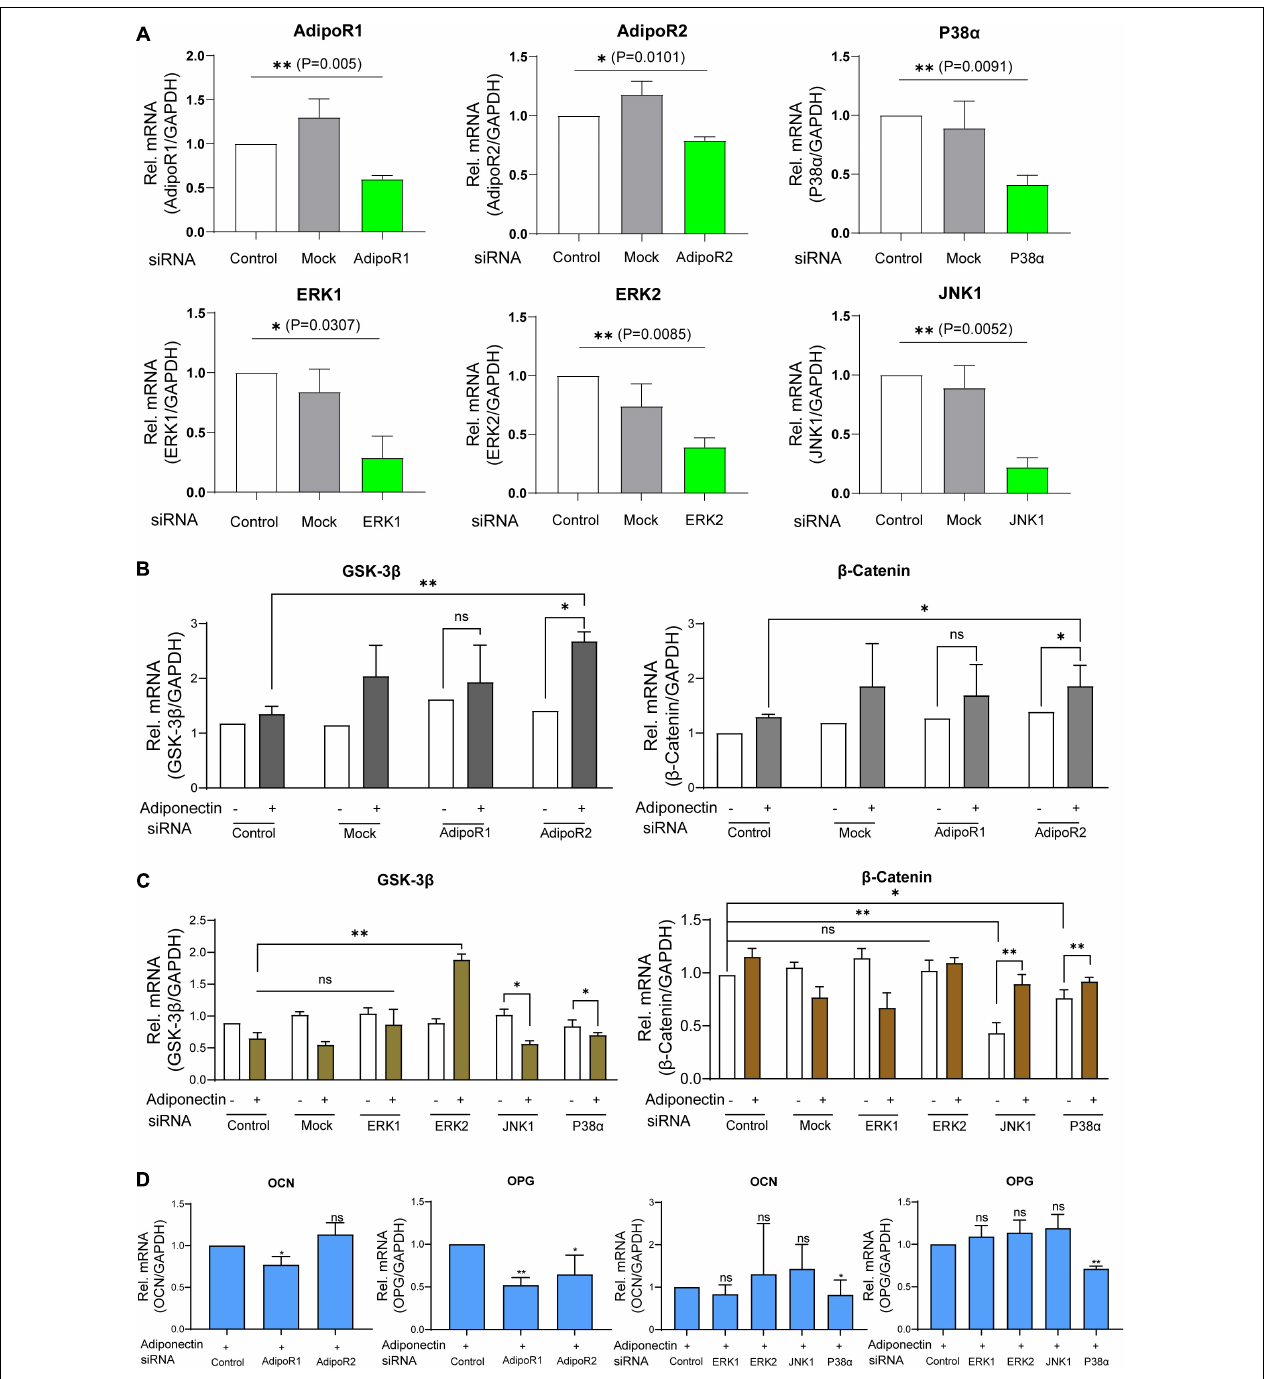
FIGURE 5 | Adiponectin/AdipoR1/P38 α cascade is particularly involved in adiponectin-induced cementogenesis. (A) The efficacy of siRNA transfections was analyzed by RT-PCR analysis. (B) Single knocking down of AdipoR2 in the presence of adiponectin has a positive effect on GSK-3 β gene expression and significantly increases β -catenin expression ( ∗ p < 0.05). (C) The single silencing of ERK2 causes increased gene expression of GSK-3 β after adiponectin addition ( ∗∗ p < 0.01). Silencing of P38 α and JNK1 slightly activates GSK-3 β gene expression. After adiponectin addition, its expression was significantly decreased ( ∗ p < 0.05). Single suppression of P38 α or JNK1 significantly decreased β -catenin expression ( ∗∗ p < 0.01 and ∗ p < 0.05, respectively), an effect that was restored after adiponectin addition in both groups. (D) Single knocking down of AdipoR1 or AdipoR2 has a down-regulating effect on OCN ( ∗ p < 0.05) and OPG ( ∗∗ p < 0.01) mRNA expression. The single silencing of P38 α causes a significant down-regulation of OCN ( ∗ p < 0.05) and OPG gene expression in the present of adiponectin (100 ng/ml) ( ∗∗ p < 0.01). These effects were not observed by ERK1 , ERK2 , and JNK1 single suppression. Asterisks indicate statistical significance ( ∗∗∗ p < 0.001, ∗∗ p < 0.01, and ∗ p < 0.05; ns, not significant).